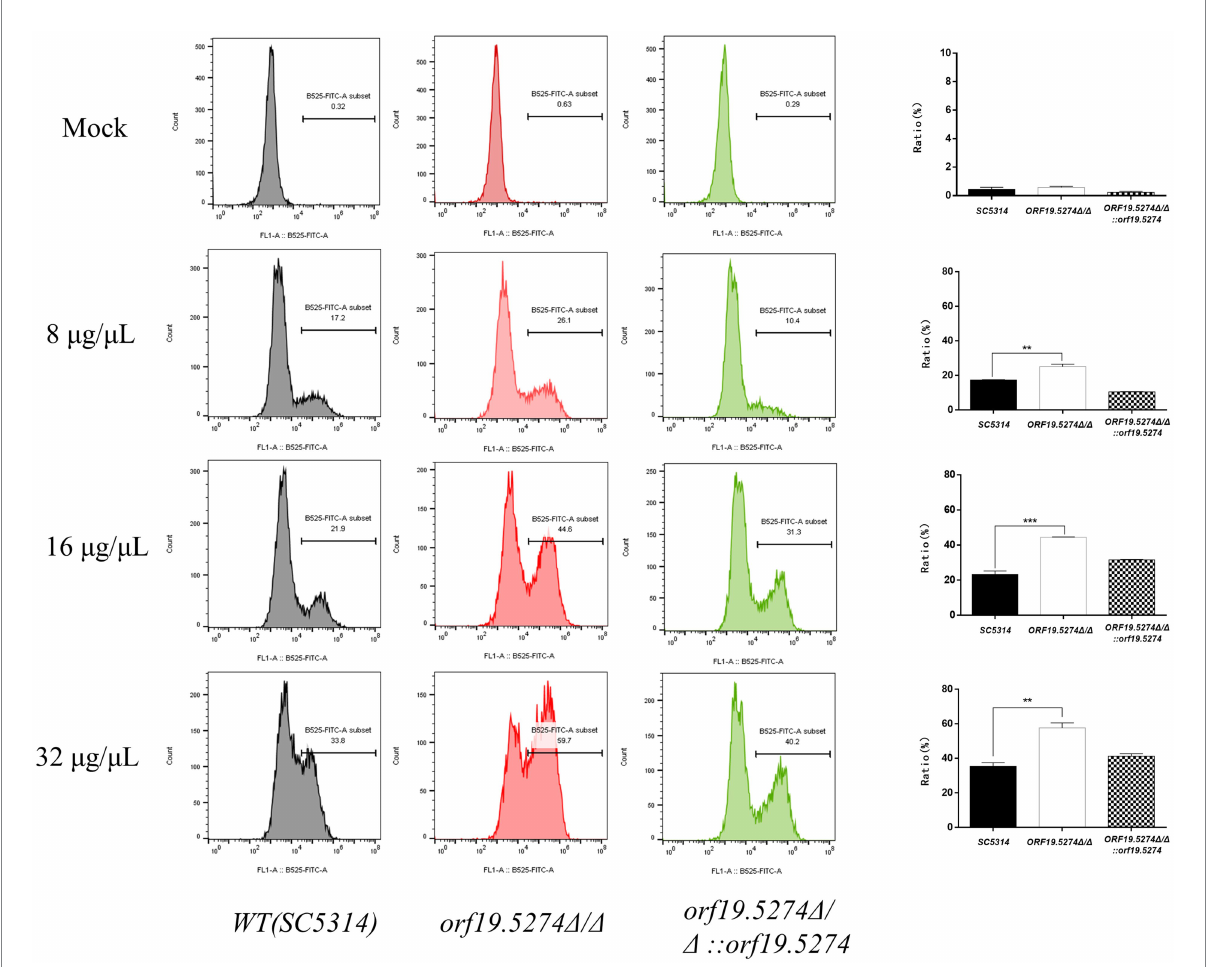
FIGURE 7 The effect of FLC on the intracellular ROS level of Candida albicans cells. The ratio between gated cells and DCFH-DA positive cells in the SC5314, orf19.5274 Δ / Δ , orf19.5274 Δ / Δ ::ORF19.5274 strains, respectively, without FLC treatment or with FLC treatment, was